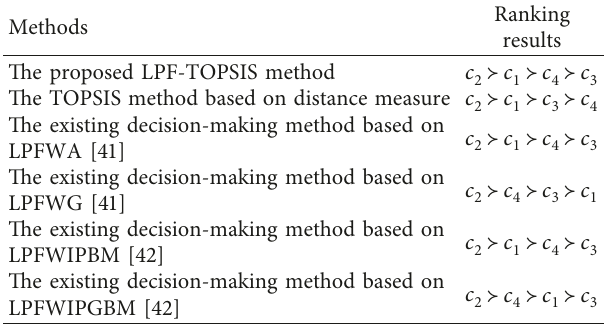
Table 3: Ranking results for various decision-making methods. Methods